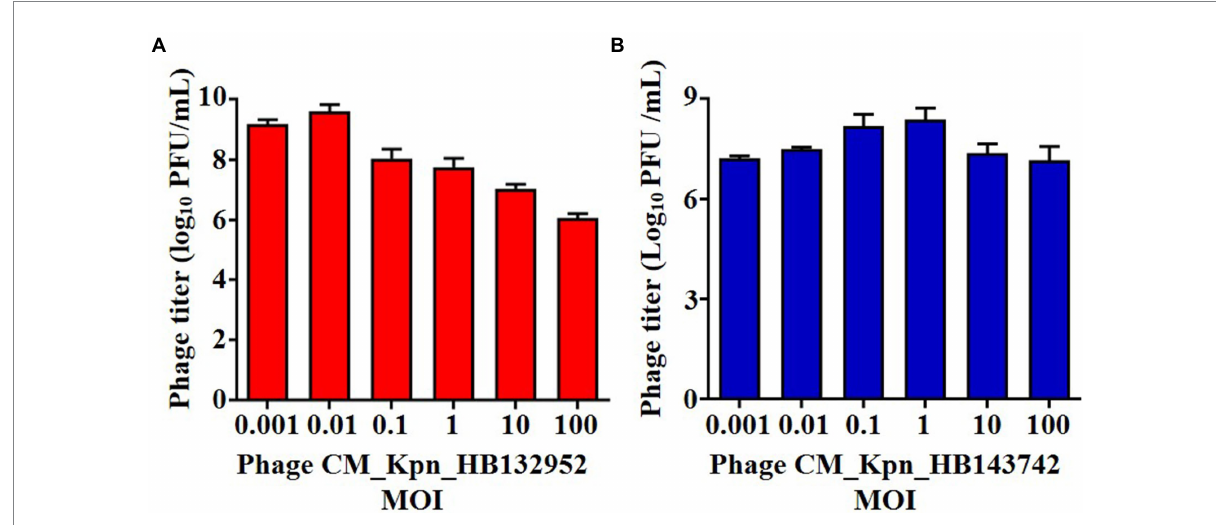
FIGURE 2 Optimal multiplicity of infection measurements of phages. (A,B) Optimal multiplicity of infection of phage CM_Kpn_HB132952 and CM_Kpn_ HB143742, respectively. Data represent Mean ± SD of three biological